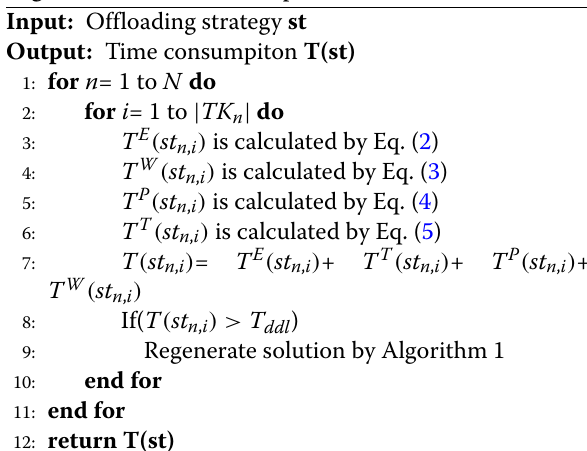
Algorithm 3 Average resource utilization calculation